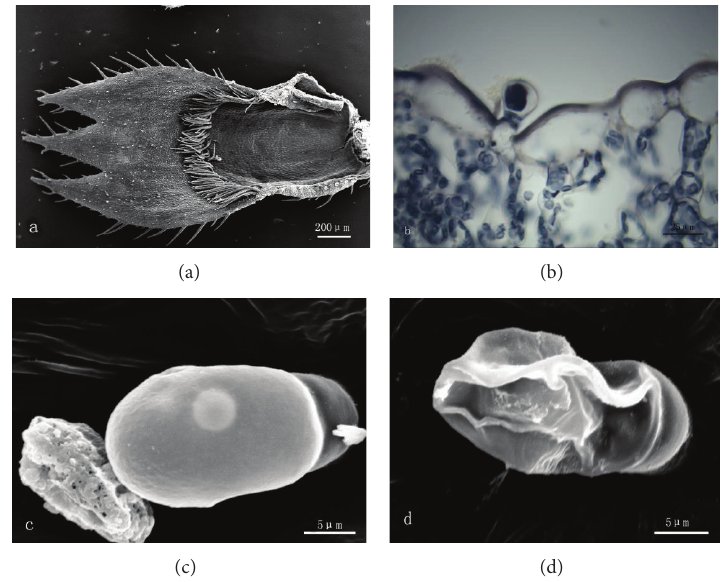
Figure 5: ((a), (c), and (d)) SEM micrographs showing the morphology of capitate trichomes on inner side of calyx. (a) The distribution of capitate trichomes. (b) Transverse section of T. quinquecostatus calyx, showing a capitate trichome. ((c), (d)) Changes of a capitate trichome.